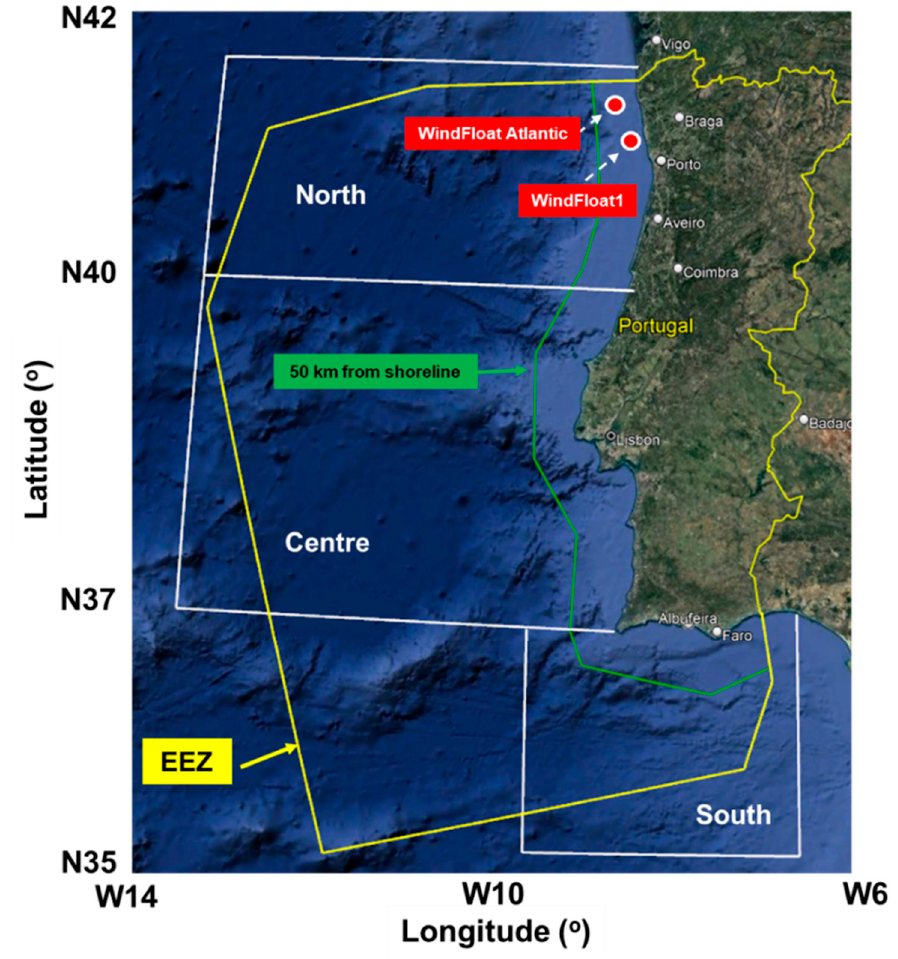
Figure 1. The Portuguese nearshore (target area). Figure processed from Google Earth 2022, including some additional information, such as the area covered by the Exclusive Economic Zone, the locations of the WindFloat projects and the separation between the coastal sectors (north, center and south).